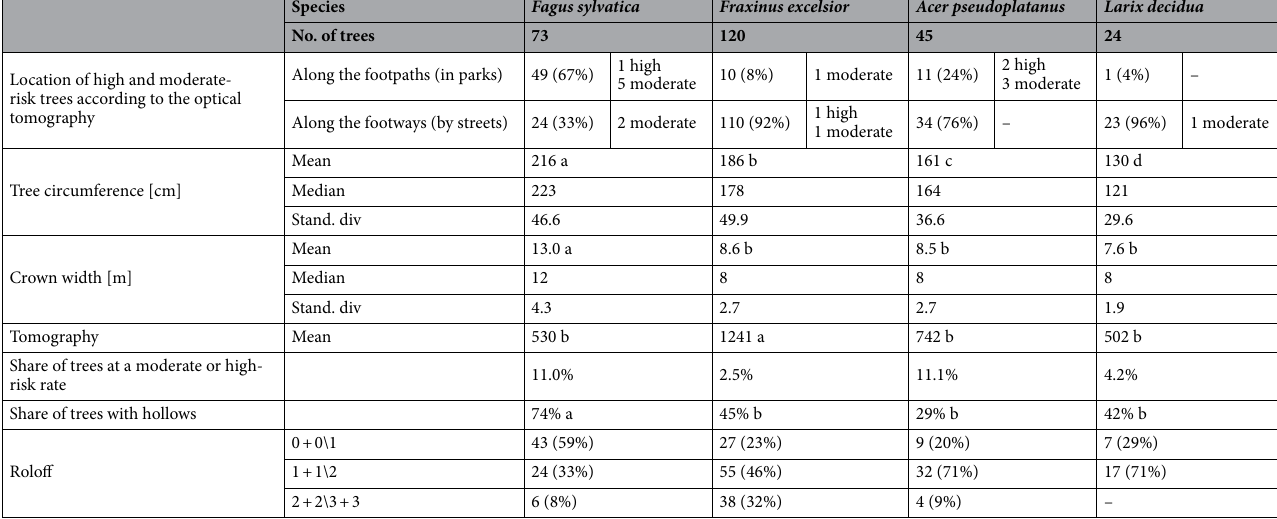
Table 5. Comparison of the characteristics of the examined trees of four species: F. sylvatica , Fraxinus excelsior, Acer pseudoplatanus and Larix decidua . Comparison of circumference, the width of tree crowns and optic tomography results using the Kruskal–Wallis H-test. According to Dunn’s multiple comparisons test, species denoted by different letters differ in given characteristics. Comparison of proportions of trees with hollows and/or fungi performed with pairwise proportion test with Holm correction. The relationship between the species and Roloff’s classes was analysed using the chi-square test of independence. All presented relationships are significant at a p value <